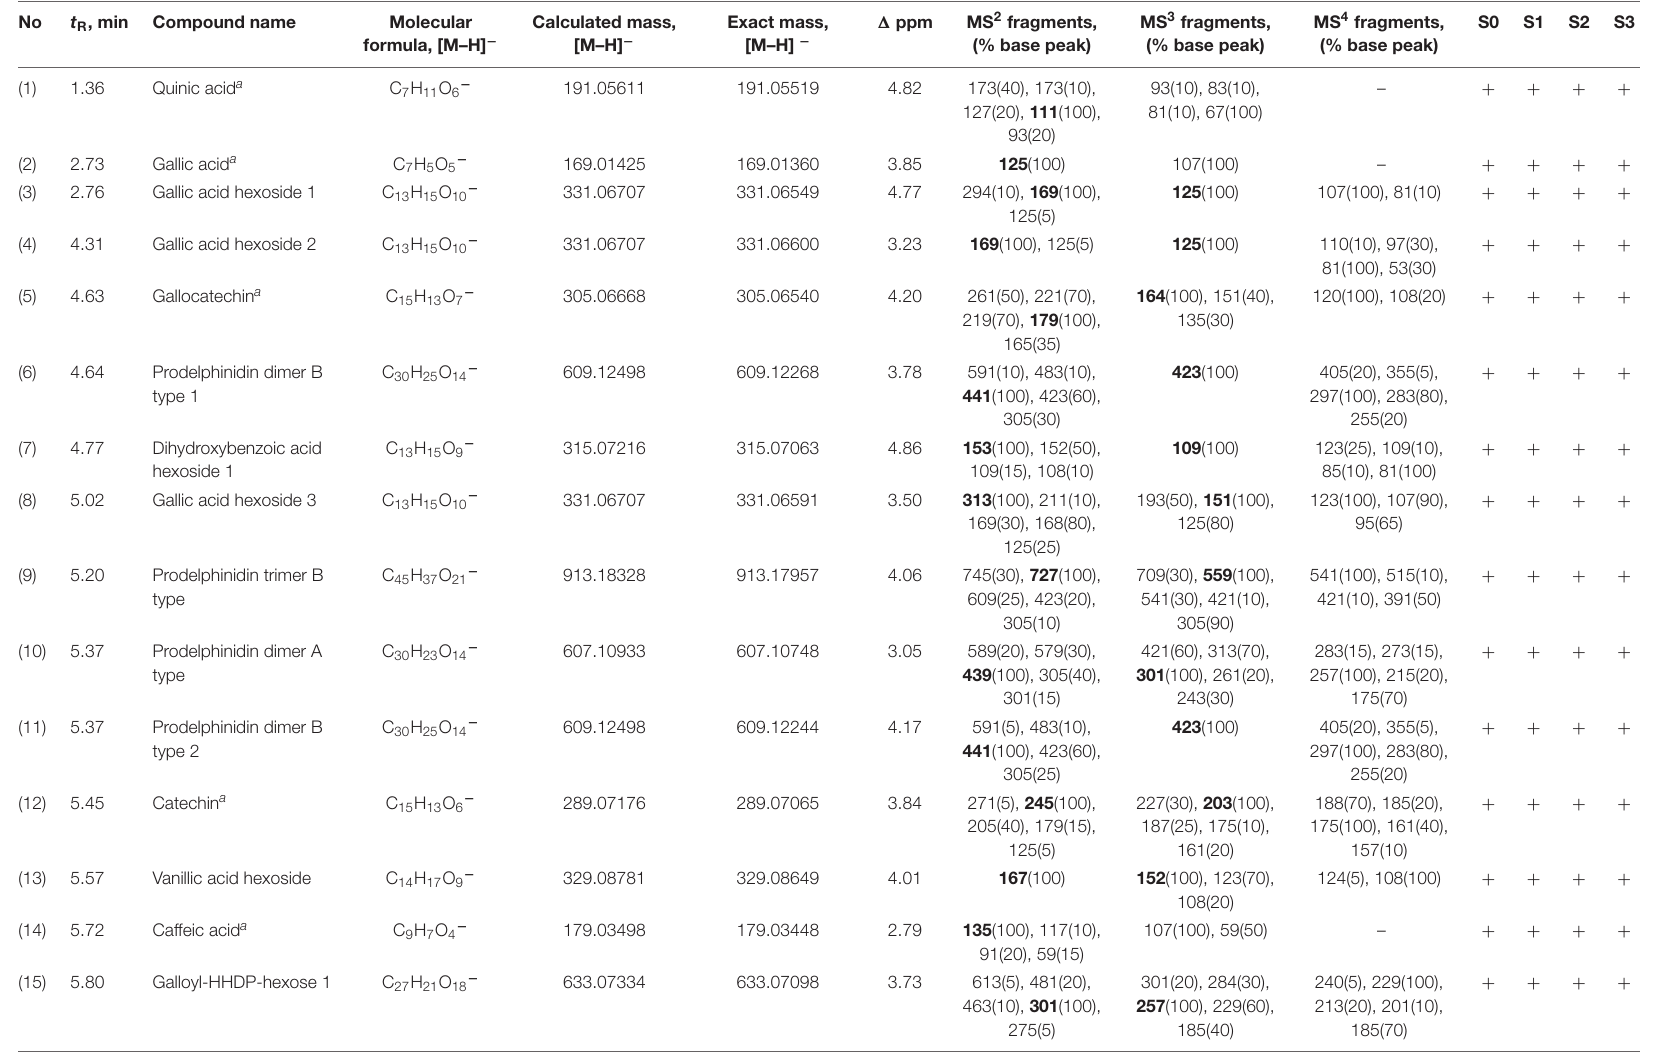
TABLE 1 | UHPLC-MS/MS Orbitrap metabolic fingerprinting of methanol extracts of Cistus creticus spp. creticus flowers (S0) and leaves of three developmental stages